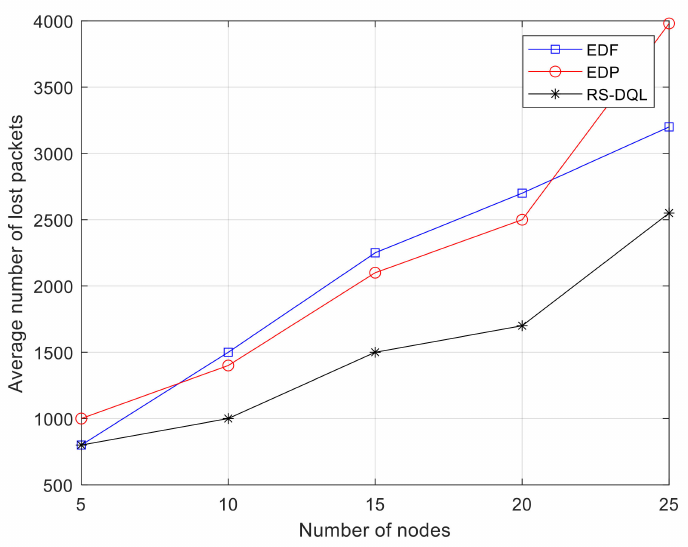
Figure 8. The number of lost packets under random data generation